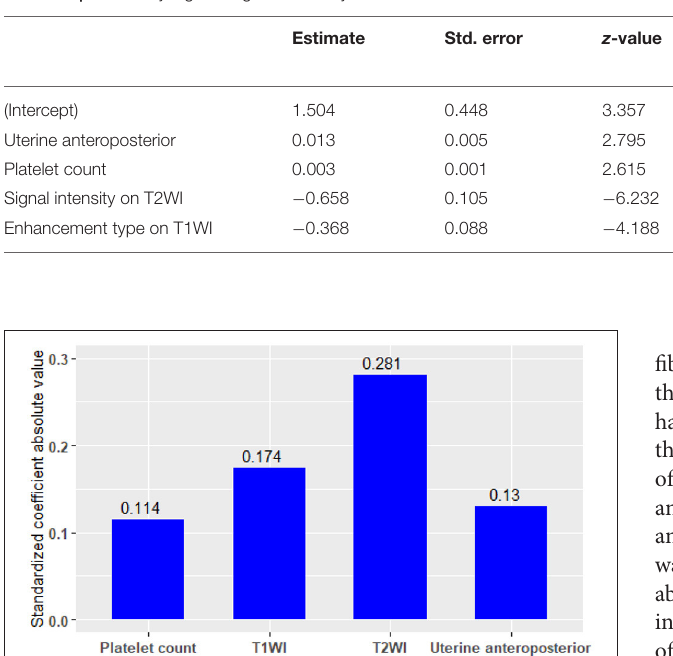
TABLE 3 | The binary logistic regression analysis of variance.